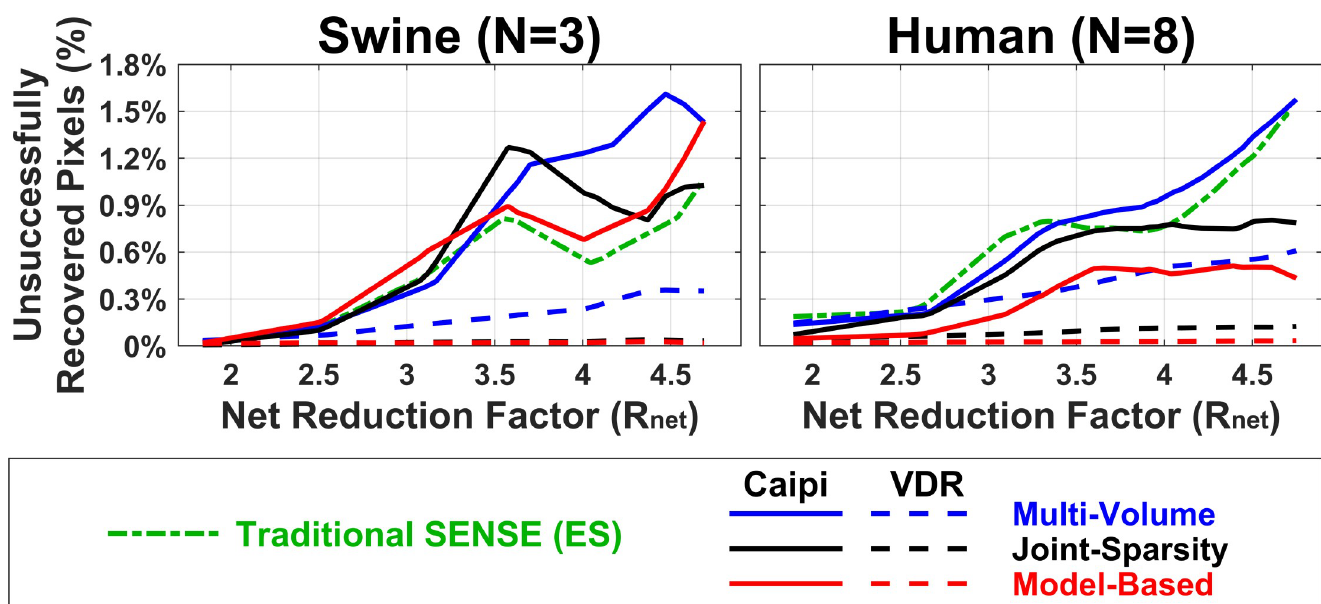
Fig 9. Average percentage of unsuccessfully recovered pixels in response to increases in acceleration rate. Percentage of pixels with T2 beyond 15 ms and 100 ms in LV ROI are regarded unsuccessfully recovered and averaged over 3 na ï ve animals (left) or 8 normal human subjects (right). Higher numbers of unsuccessfully recovered pixels indicate decreased robustness to undersampling and potential loss of information. VDR sampling with either joint-sparsity SENSE and model-based SENSE reconstruction yields a high degree of pixel recovery, maintaining very low percentages of unrecovered pixels for all Rnet.